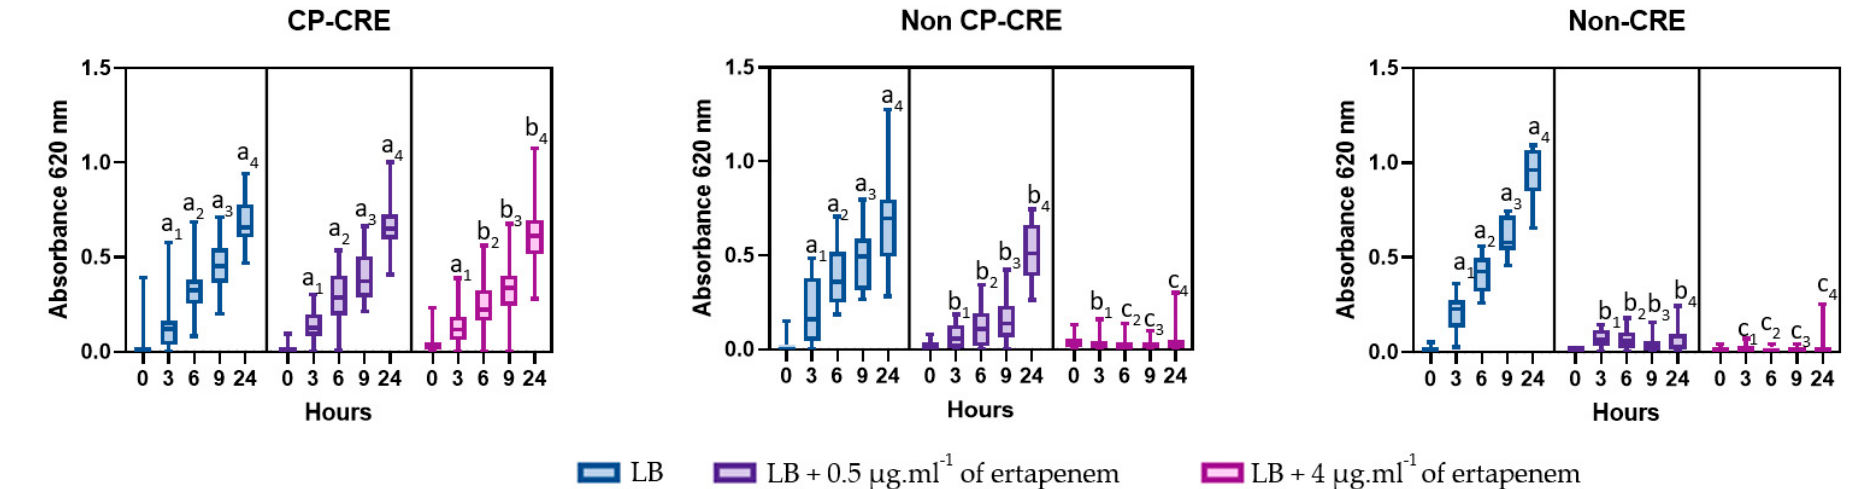
Figure 1. Growth over time according to ertapenem concentration (0, 0.5 or 4 µ g · mL − 1 ) for carbapenemase-producing-carbapenem-resistant-Enterobacterales (CP-CRE; n = 57), non-carbapenemase-producing-carbapenem-resistant-Enterobacterales (non-CP-CRE; n = 23) and non-carbapenem-resistant Enterobacterales (Non-CRE; n = 11). The same underscript number to a letter reflects time-point specific analyses. Whiskers correspond to min and max values. Different letters above bars indicate significant differences between ertapenem concentration as determined by Fisher’s LSD test ( p < 0.05).